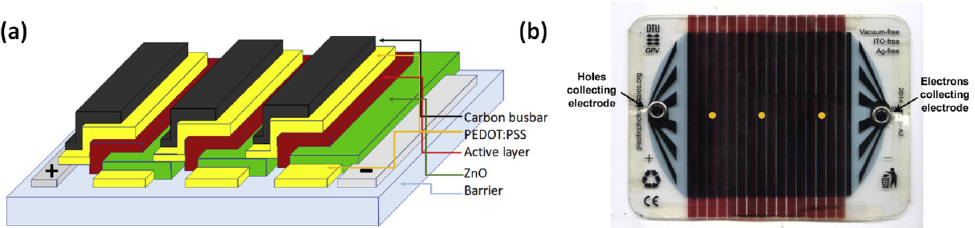
Figure 7. ( a ) Layer structure of the investigated photovoltaic module. ( b ) Photograph of the freeOPV module [46]. (Reproduced from Ref. [46], 10.1016/j.synthmet.2018.12.015, with permission.)